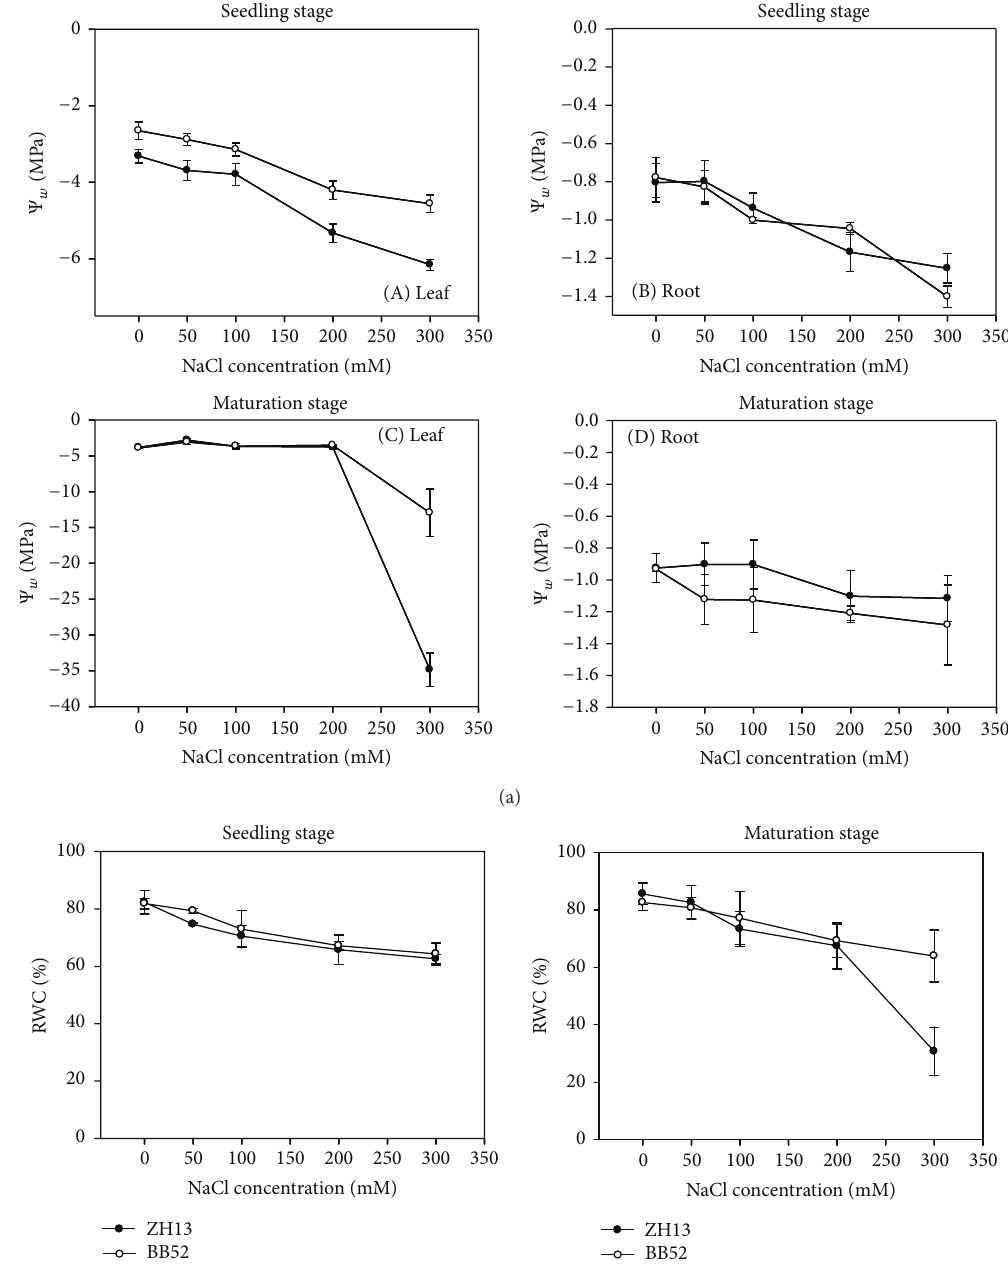
Figure 1: Changes of water potential ( 𝜓 w , A) and relative water content (RWC, B) under salt stress.